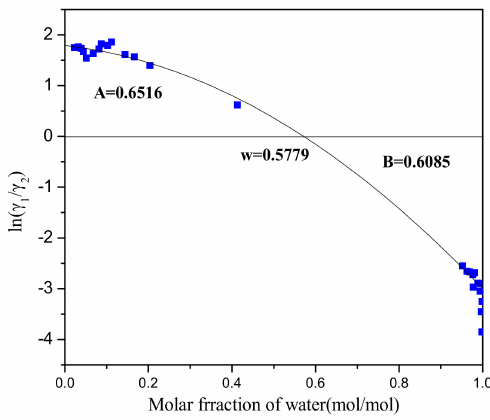
Figure 2. Thermodynamic consistency test. (A: The area above the x -axis; B: The area below the x -axis; ω : The point of intersection with the x